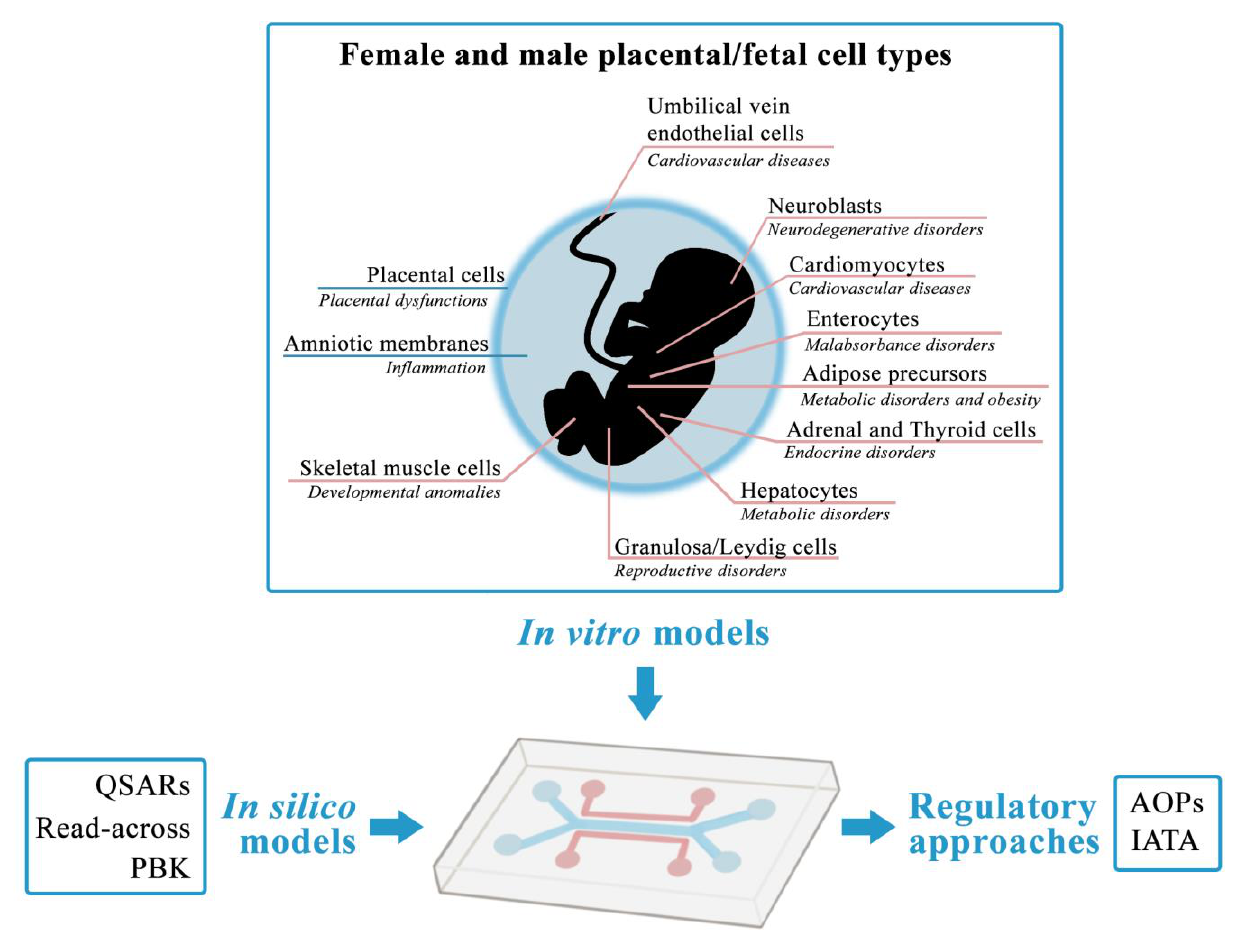
Figure 2. Requirements of a future feto–placental-OoC platform with the list of the cell type that can be implemented in the model. Fetal cells can be obtained from legal abortive material (9–12 weeks of gestation). A limited number of donors are required, also for amniotic and placenta cells. Immortalization of all these cell types will allow long-lasting availability of such cells. Possible associated chronic diseases which could be investigated through the model are indicated below each cell type.